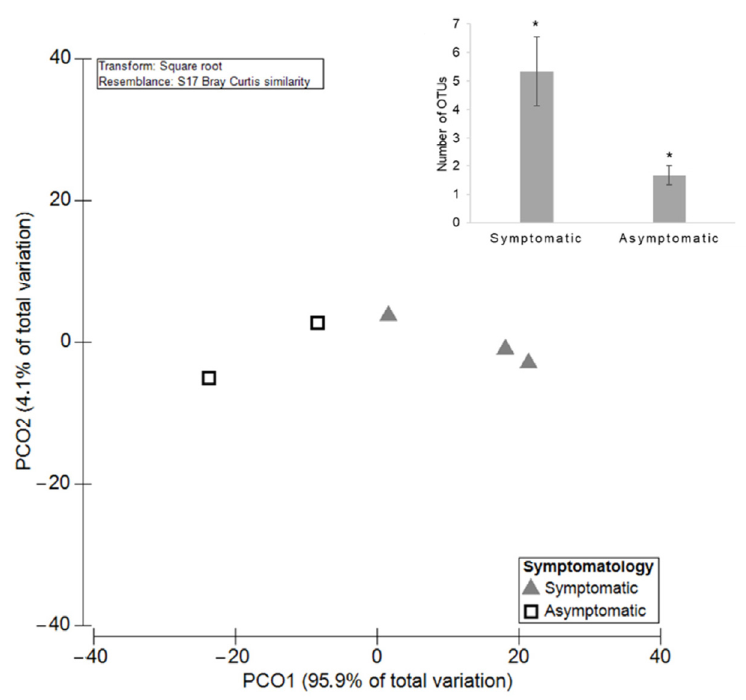
Figure 5. Principal Coordinates Analysis (PCO) based on the diversity of the GTDs-associated fungi among symptomatic and asymptomatic grapevines. The average of the total OTUs number for both groups is shown in bar plot and significant differences ( p < 0.05) are indicated by asterisks.